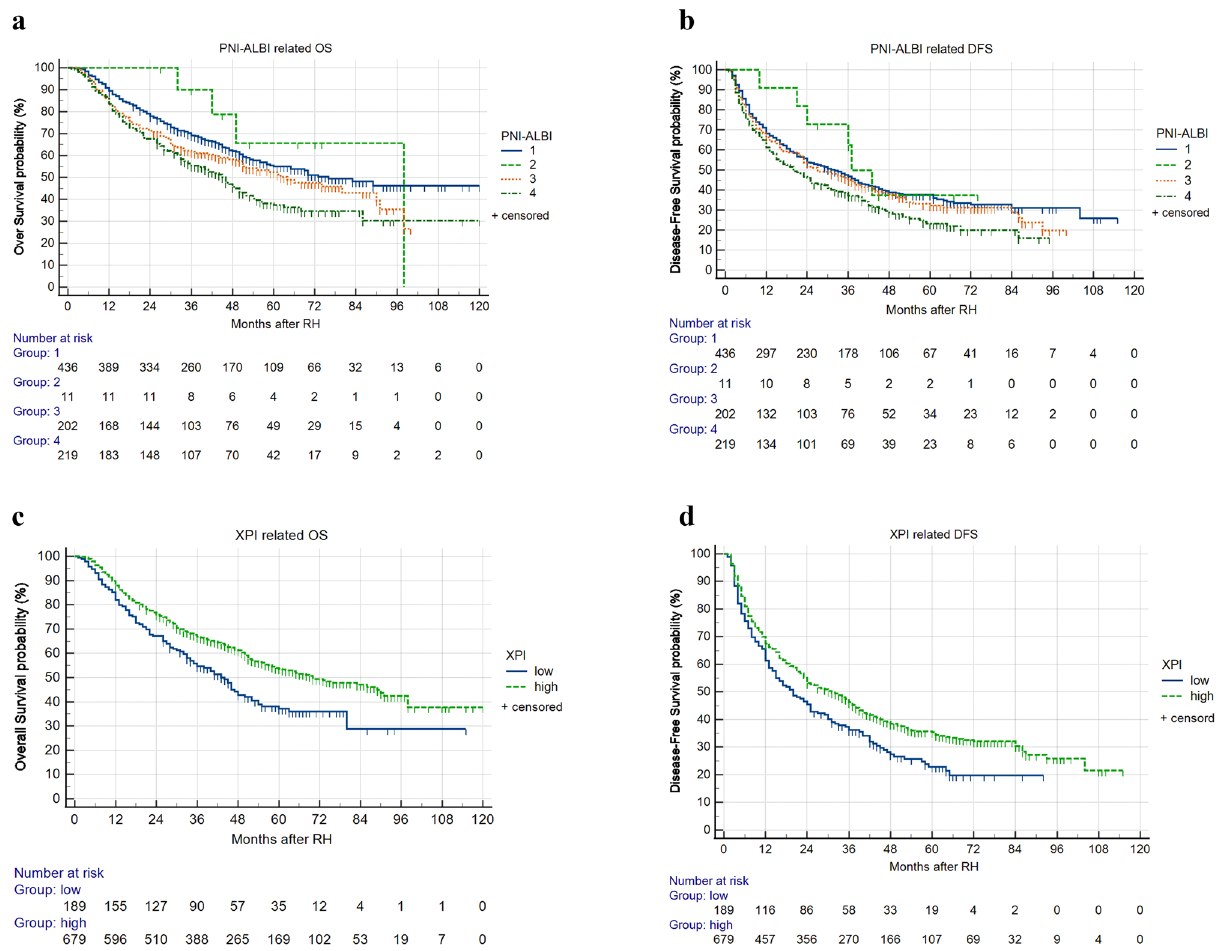
Figure 3. Relationship between PNI-ALBI or XPI and DFS or OS of HBV-HCC patients undergoing RH. ( a ) Relationship between PNI-ALBI and OS. ( b ) Relationship between PNI-ALBI and DFS. ( c ) OS of patients with XPI ≤ 75 was lower than those with XPI > 75 (P < 0.01). ( d ) DFS of patients with XPI ≤ 75 was lower than those with XPI > 75 (P < 0. 01).